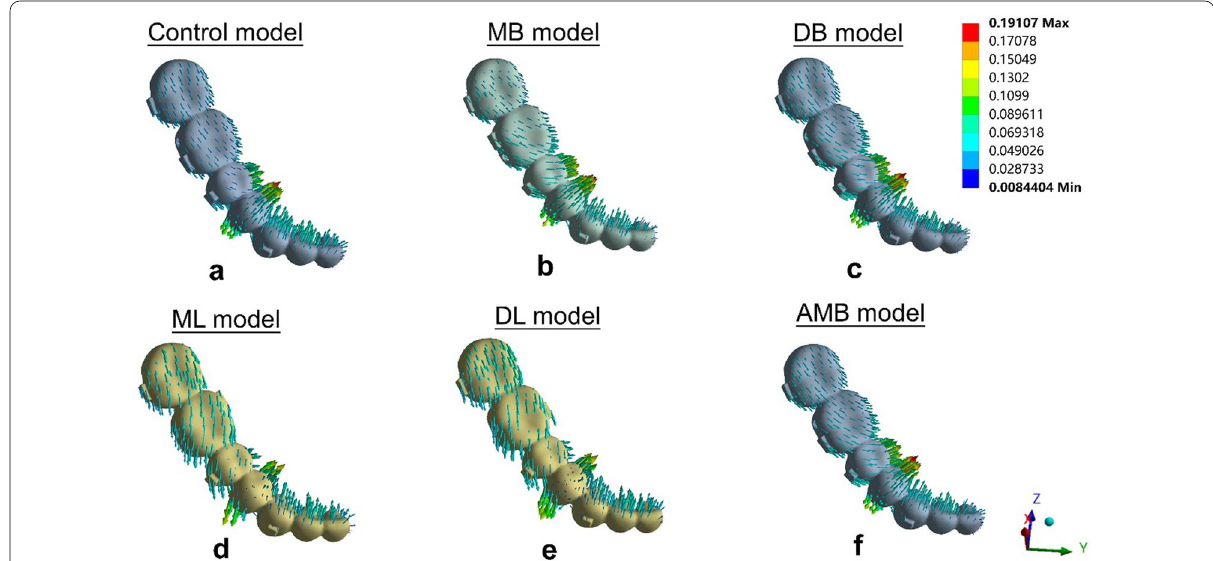
Fig. 5 Tendencies of aligner deformation of a the control model, b the MB model, c the DB model, d the ML model, e the DL model, and f the AMB model